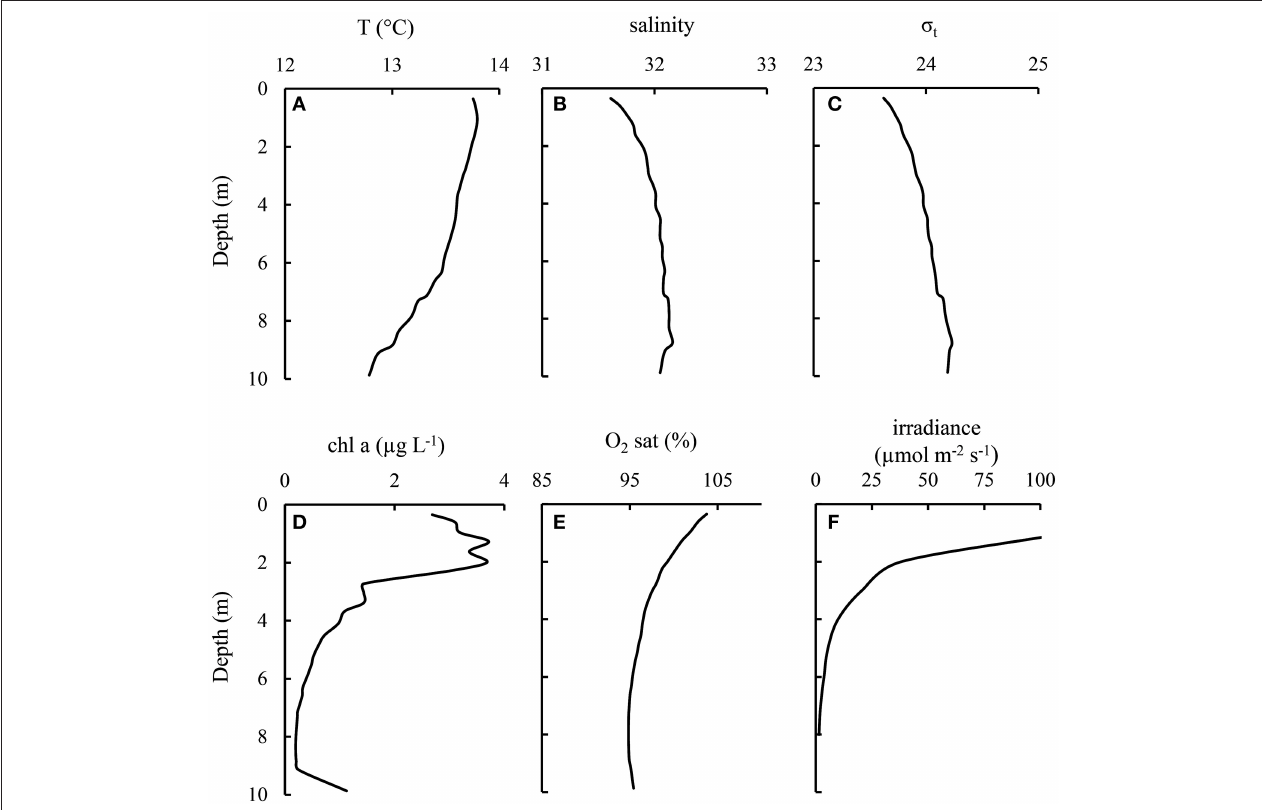
FIGURE 2 | Typical physical conditions within the mesocosms as exemplified by bag 3 ( + Si − Cops) on August 23–24 (experiment Days